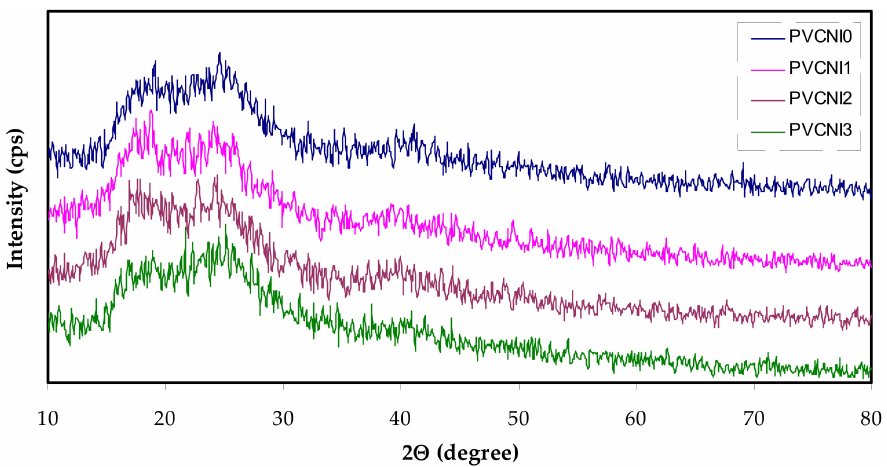
Figure 1. X-ray pattern neat PVC (PVCNI0) and PVC-based electrolytes (PVCNI1, PVCNI2 and